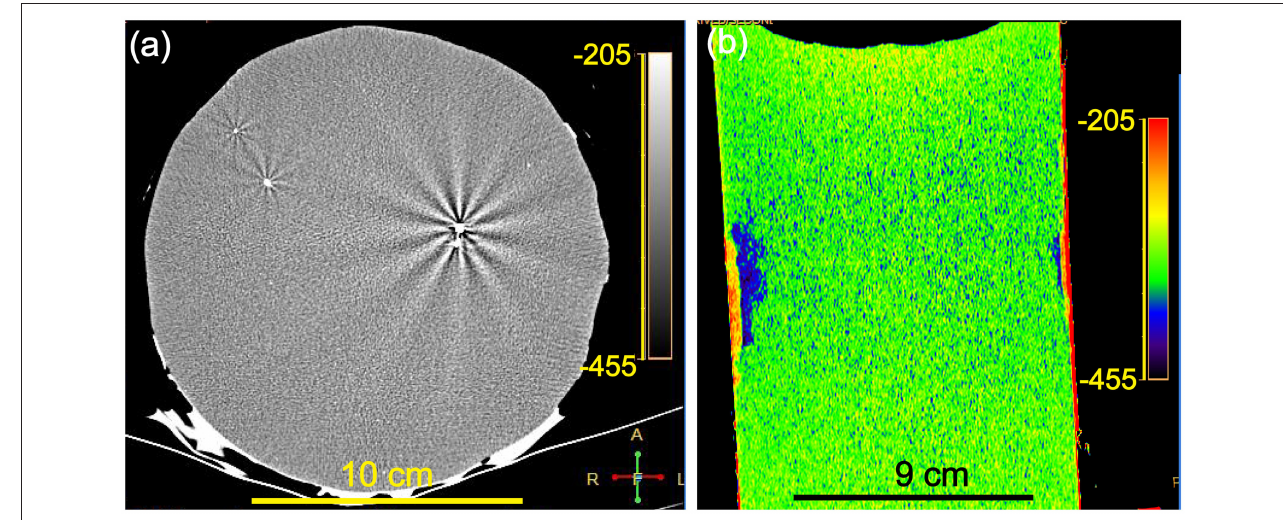
FIGURE 4 | (a) CT image for a high-density heterogeneous crystal impurity in Li-B alloy. (b) CT image for the Li-B alloy at the z-axial section.